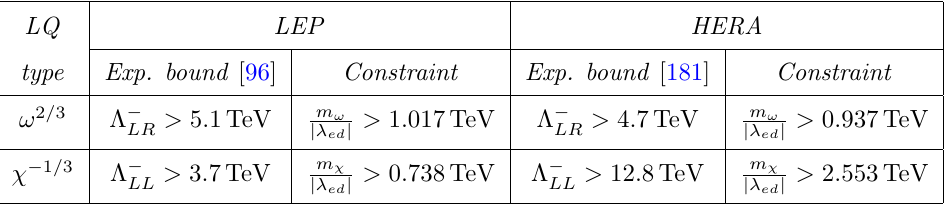
Table 16 . Constraints on the ratio of LQ mass and the Yukawa coupling from LEP [96] and HERA [181] contact interaction bounds.